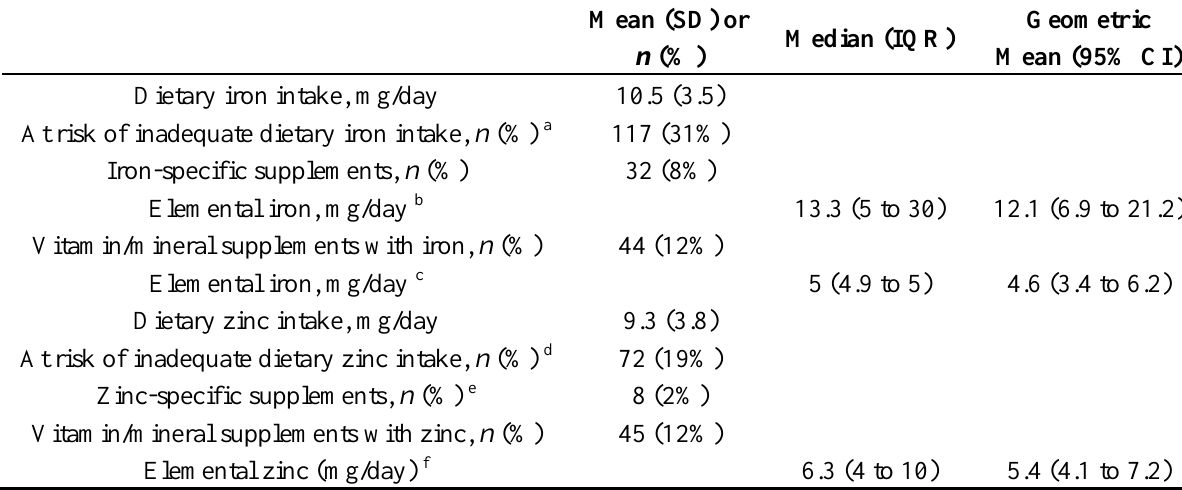
Table 3. Dietary and supplemental iron and zinc intakes in women aged 18–50 years ( N = 379).